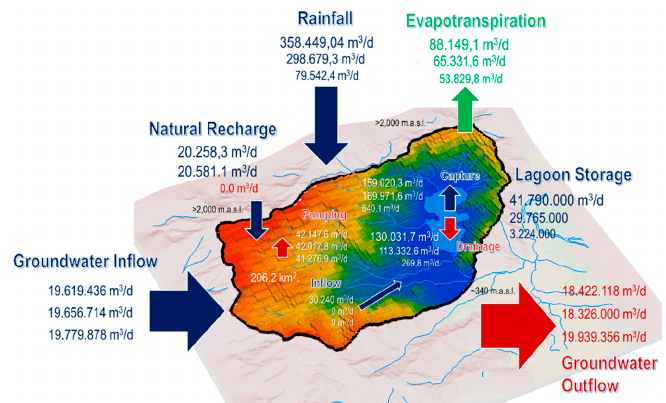
Figure 6. Simulation results of the surface and groundwater balance of the Aculeo basin and its lagoon, for each 5-year simulation period (2006–2011, 2012–2017, and 2018–2023). Each flux of the water balance has three values representing each simulation period, going from normal to dry conditions (top to bottom).